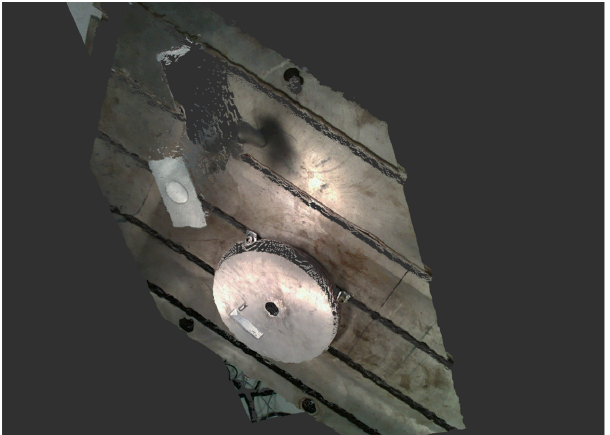
Figure 3. RGB-D cameras have poor performance when measuring smooth surfaces; significant breaks and distortions in the 3D point cloud data exist in the